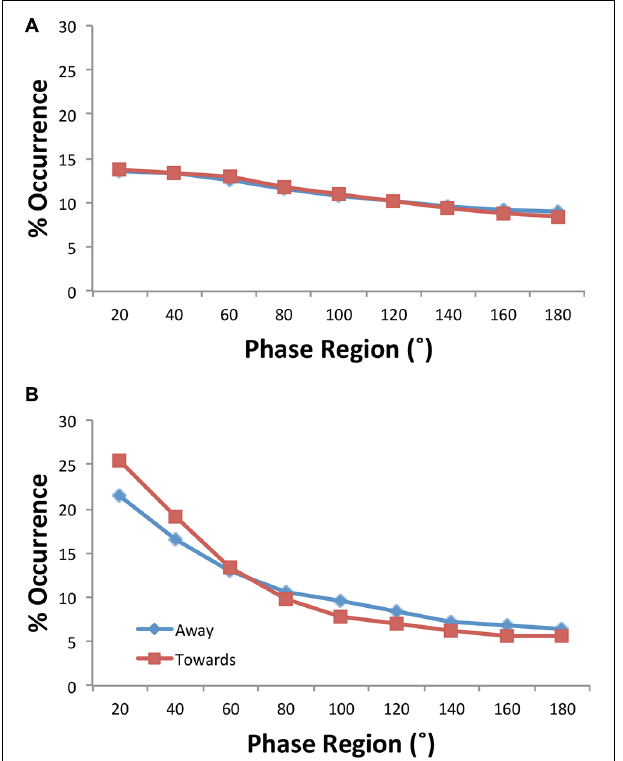
FIGURE 3 | Distributions of relative phase by facing conditions for the virtual (A) and experimental (B) participant